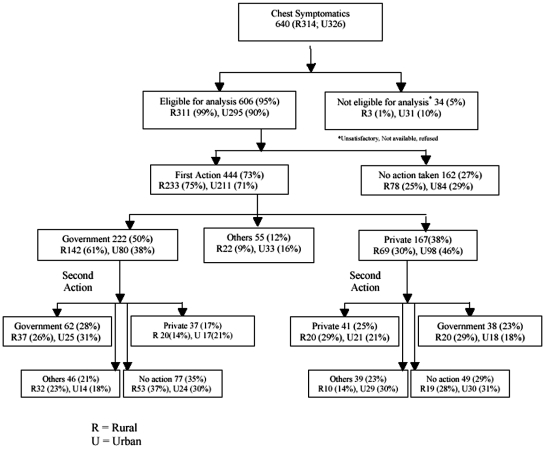
Care-seeking pattern with first provider approached (n = 640).